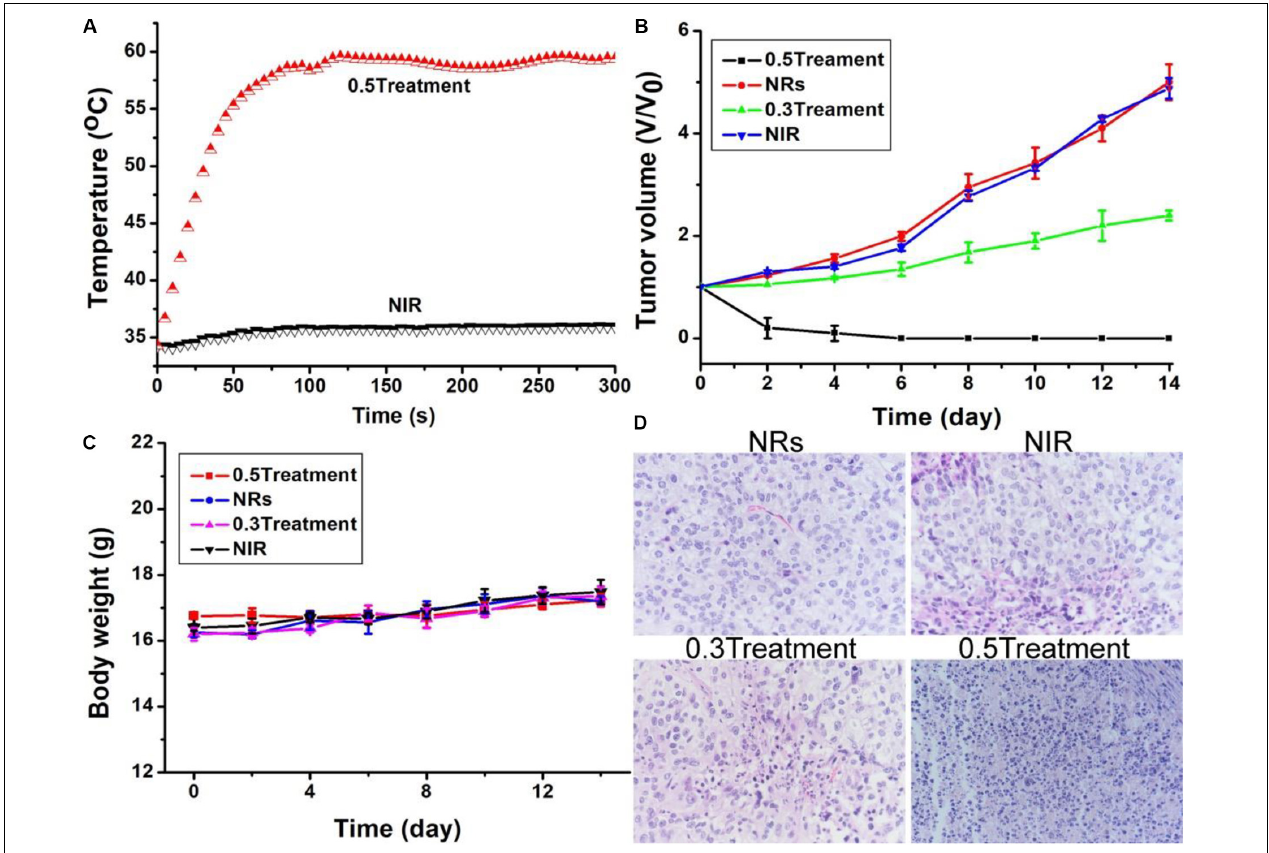
FIGURE 6 | (A) Photothermal effect after injection of PBS, and Bi 2 S 3 nanorods under the irradiation of the 808 nm laser with a power density of 0.5 W cm - 2 , respectively. (B) Tumor volume and (C) Body weight changes in different groups. (D) H&E images of ex vivo tumor sections in different groups. Magnification: 200